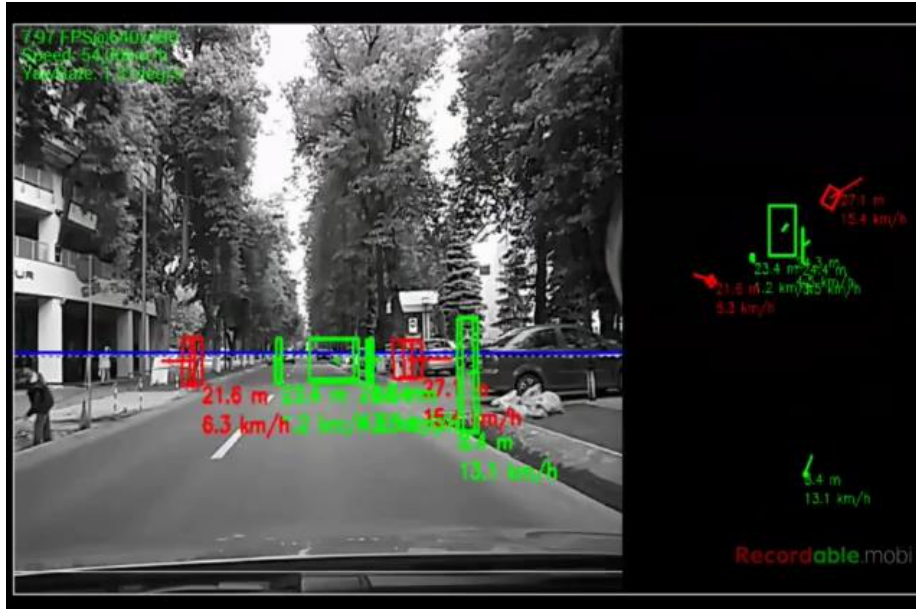
Figure 20. False positives due to shadows on the road.